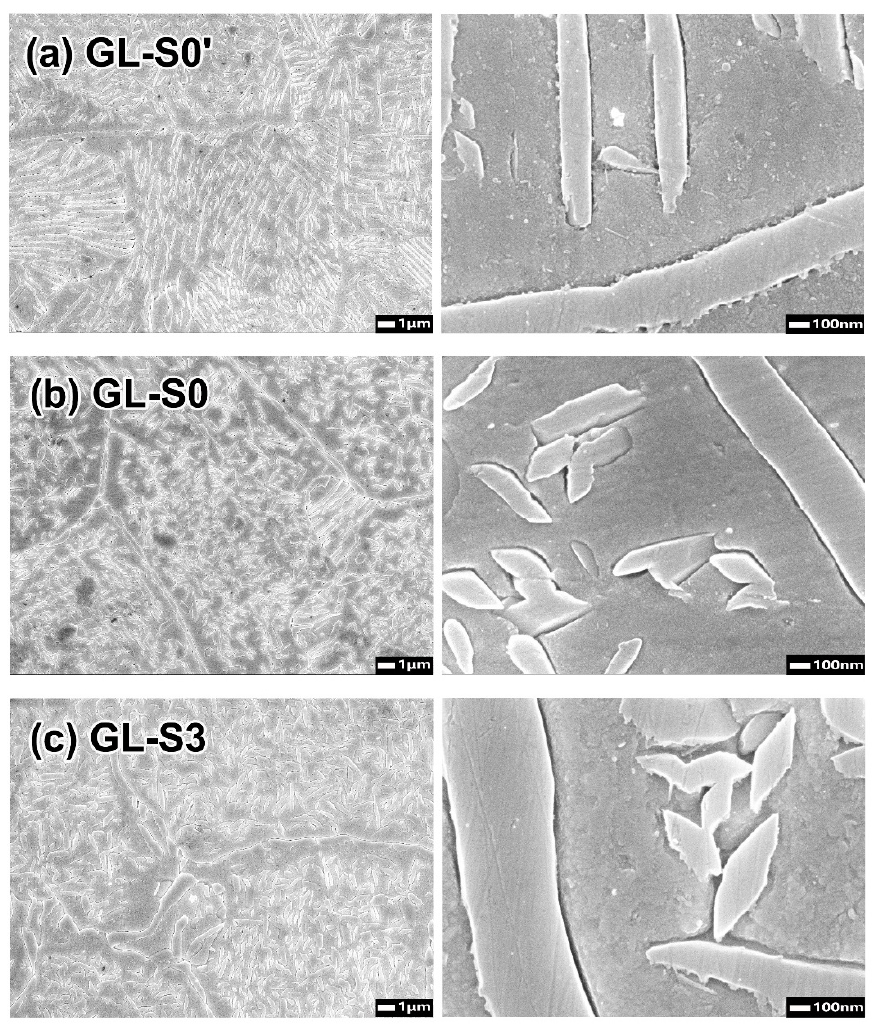
Figure 4. Microstructure after glaze (GL) (left at 5000×, right at 60,000×): ( a ) GL-S0 ′ ; ( b ) GL-S0; ( c ) GL-S3.